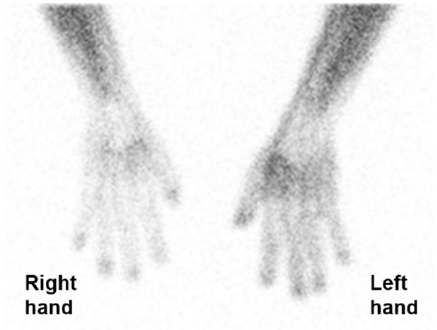
Figure 1. An image of hand perfusion scintigraphy using Tc-99m methylene diphosphonate with chilling stimulation in the right hand. The chilled right hand showed significantly decreased blood pool uptake, showing a right-to-left hand blood pool uptake ratio of 0.47.